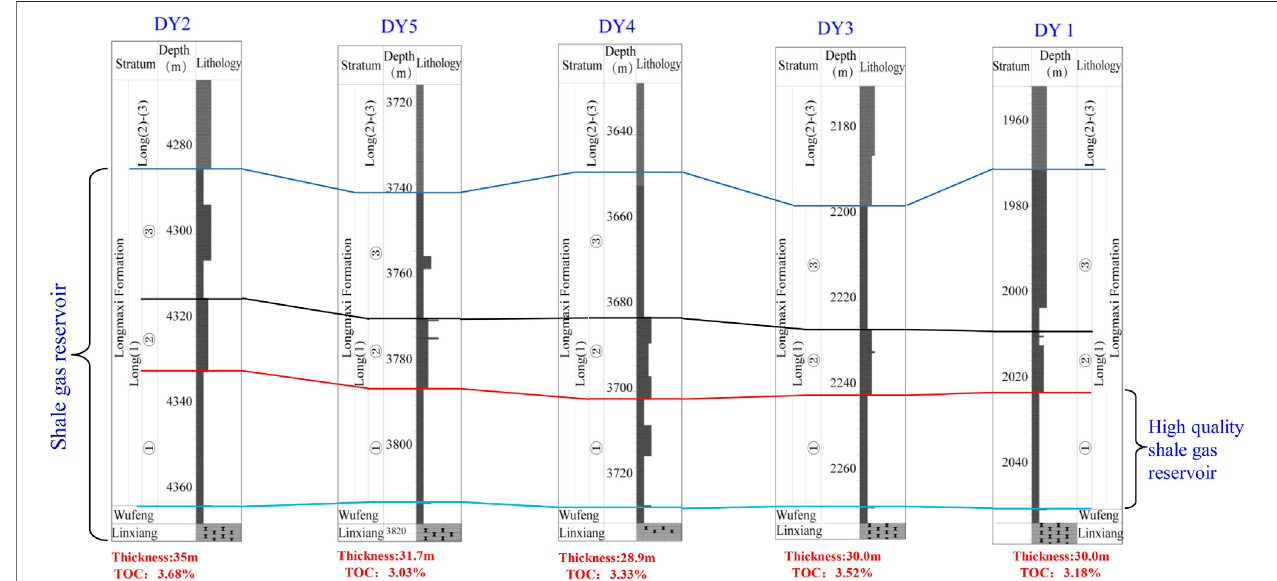
FIGURE 2 | Distribution of shale gas intervals in the Longmaxi formation of Dingshan area.